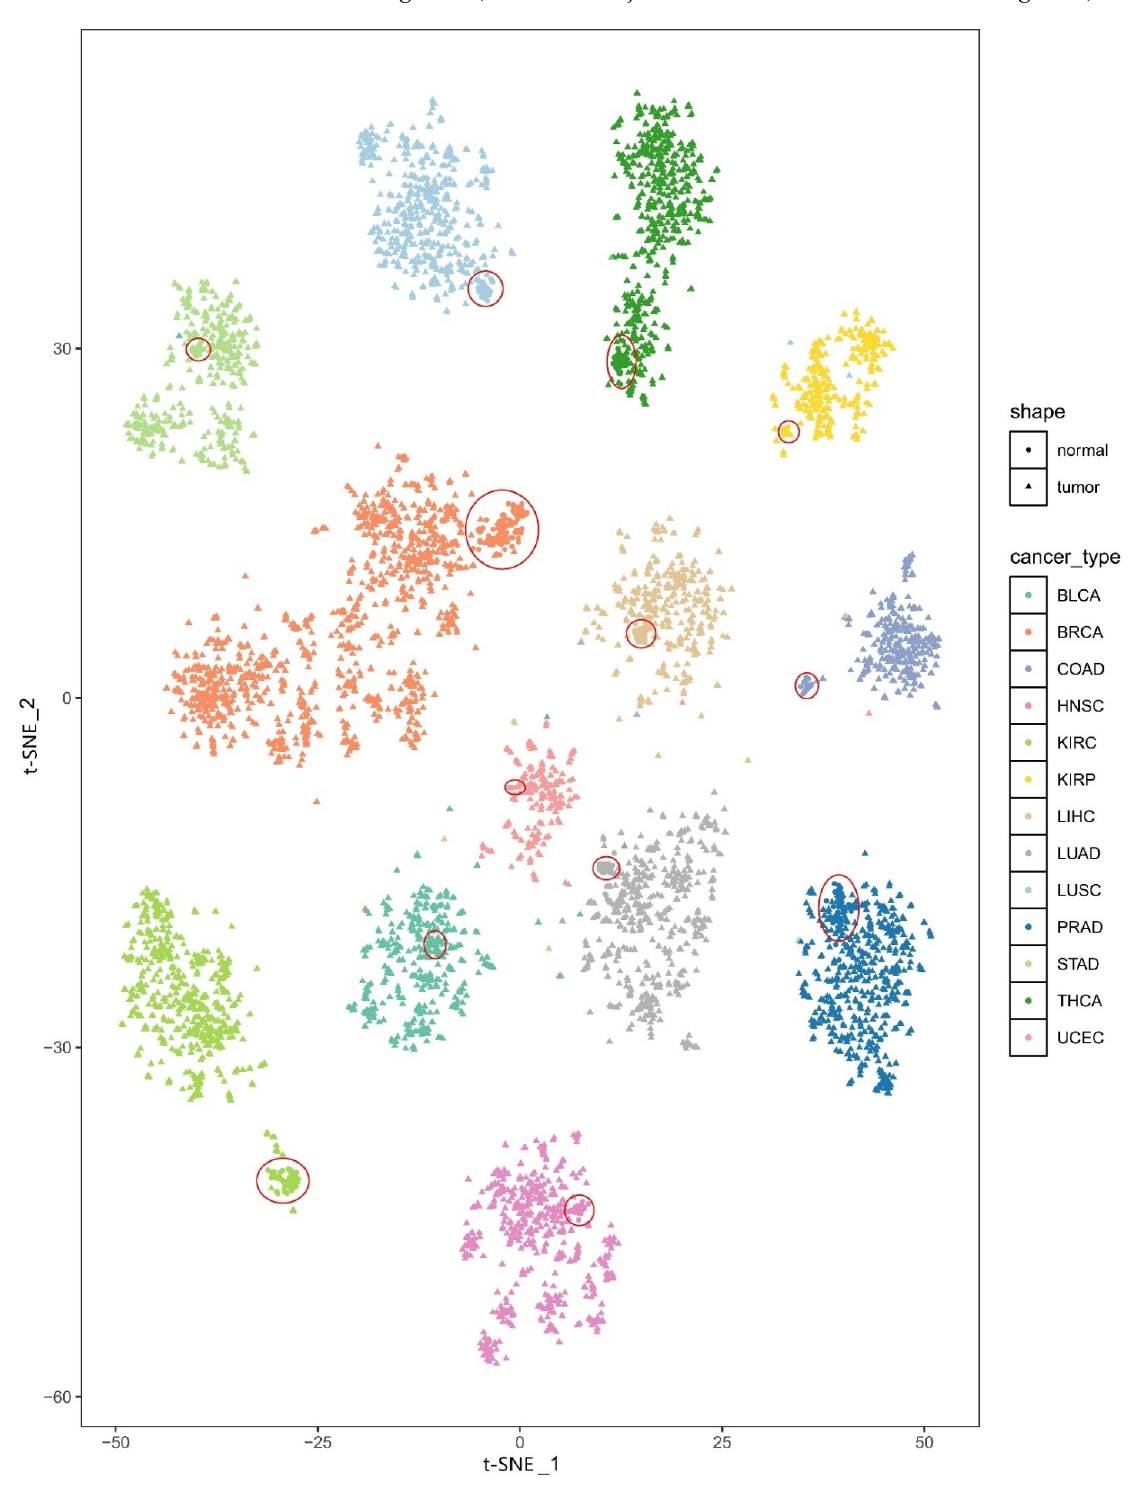
Figure 2. The t-SNE plot of the PDSs for all samples. Different colors represent different types of cancer. Triangles and dots are used to distinguish tissues of cancer types and the corresponding tumor-adjacent tissues, respectively. The red circle indicates the enrichment area of the tumor-adjacent tissues.